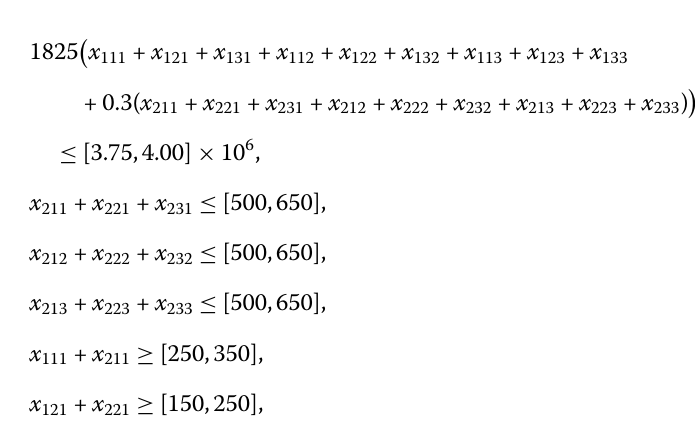
+ [–0.01658,–0.01254] x 2 133